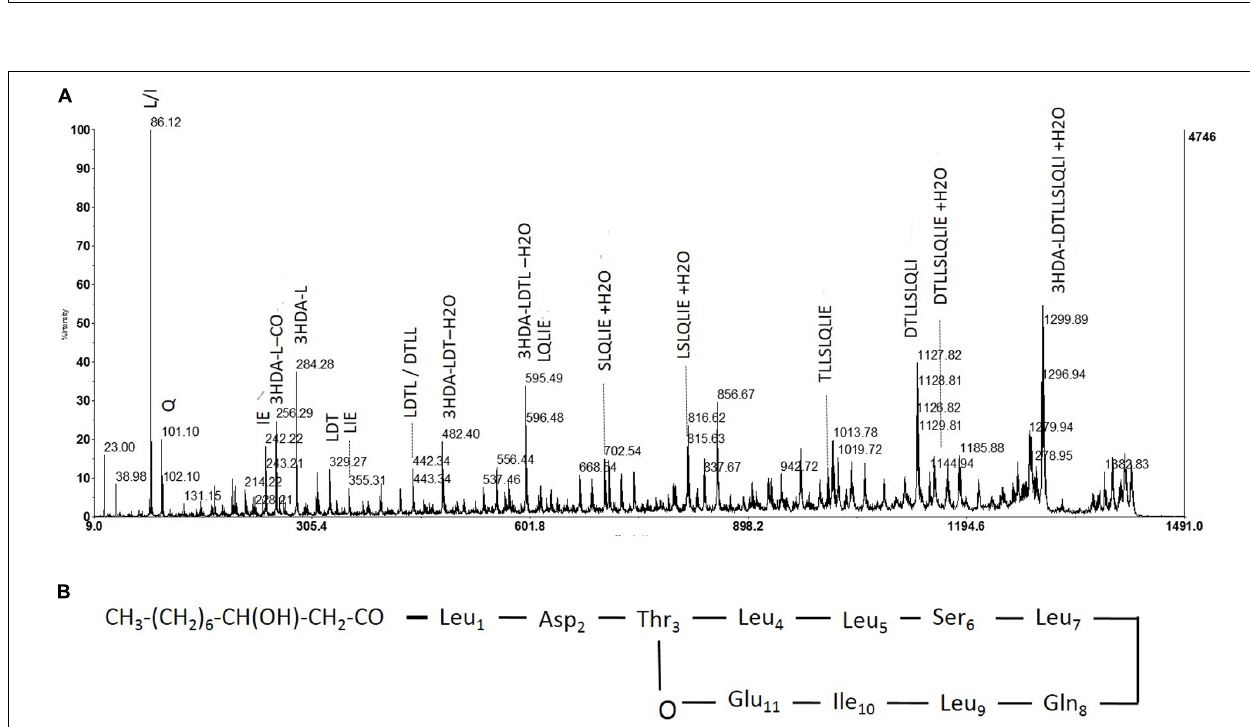
Frontiers in Microbiology |